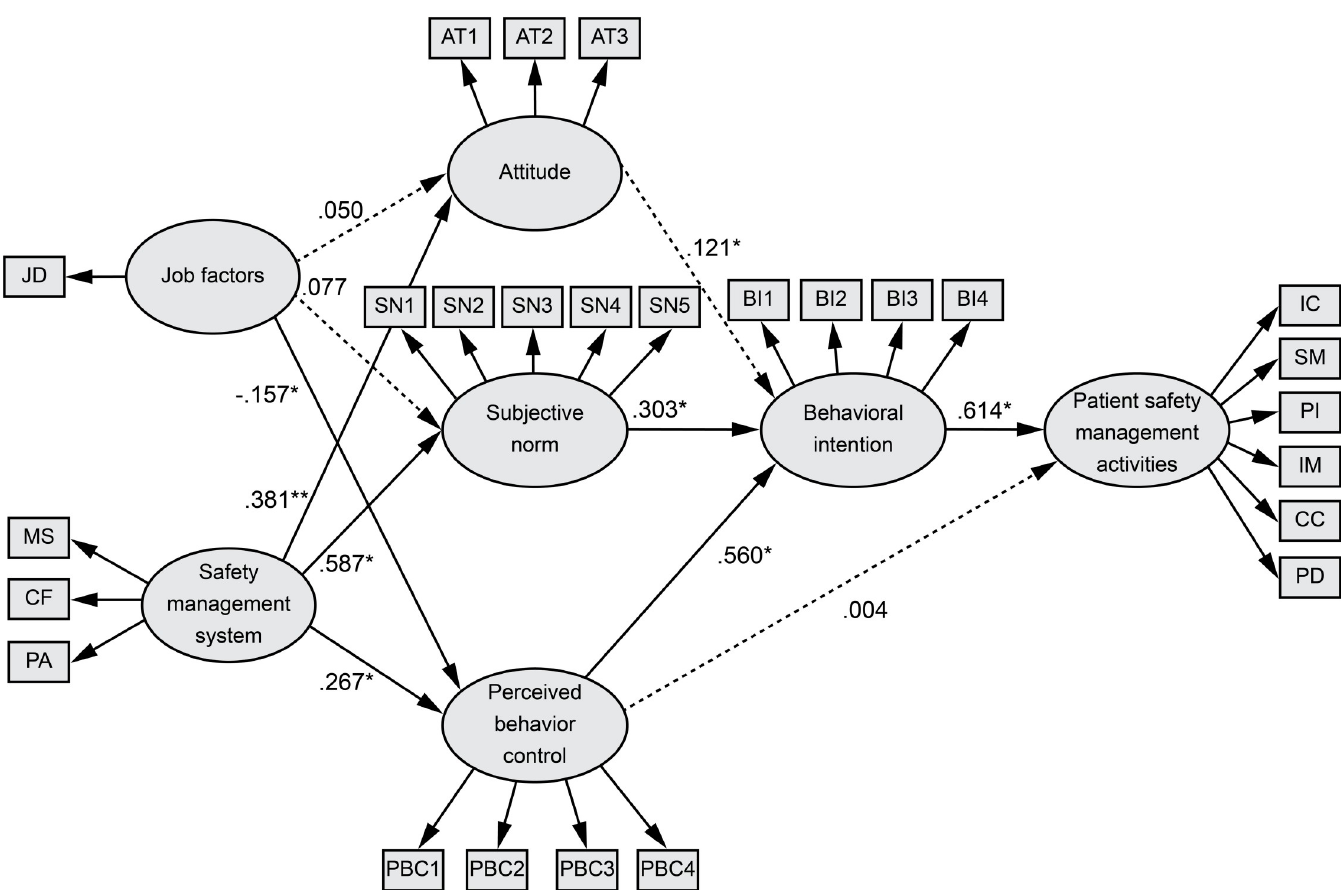
Fig 2. Path diagram of the model. JD, job demand; MS, management supervision; CF, communication and feedback; PA, participation; AT, attitude; SN, subjective norm; PBC, perceived behavioral control; BI, behavioral intention; IC, infection control; SM, specimen management; PI, patient identification; IM, item management; CC, count confirmation; PD, prevent damage. � p < .05, �� p <